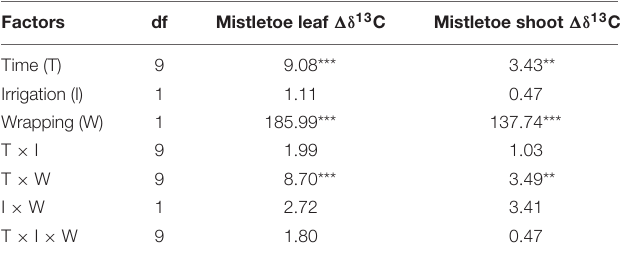
TABLE 1 | Results of linear mixed models for (cid:49) δ 13 C values (uptake and incorporation of 13 C) of bulk material in different tissues of Viscum album ssp. austriacum in the wrapping experiment (Exp. 1).